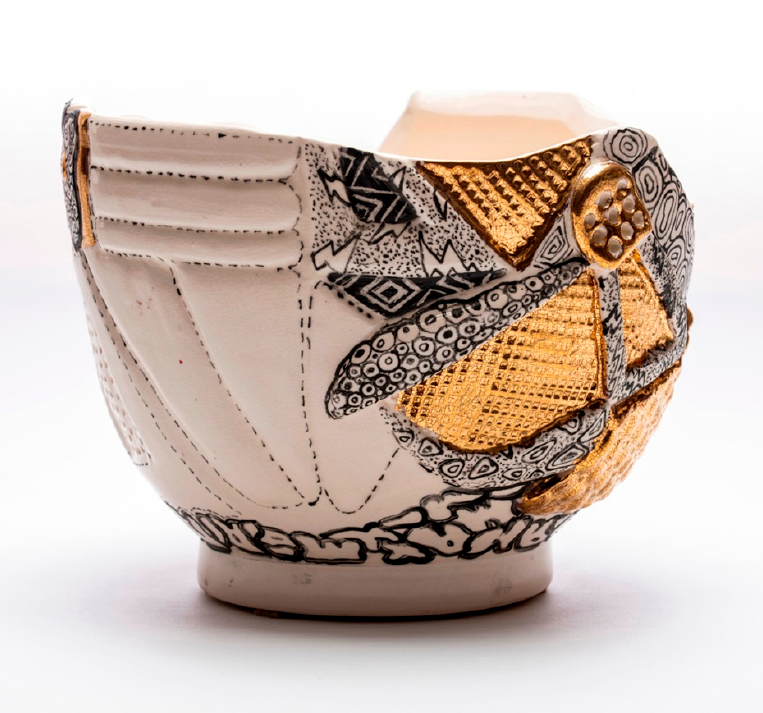
Figure 10. Stunting: Clean Joint, 2018 , Porcelain, china paint, luster, 8 × 10.5 × 10.5 in. Image by KeneK Photography, courtesy of Wexler Gallery.